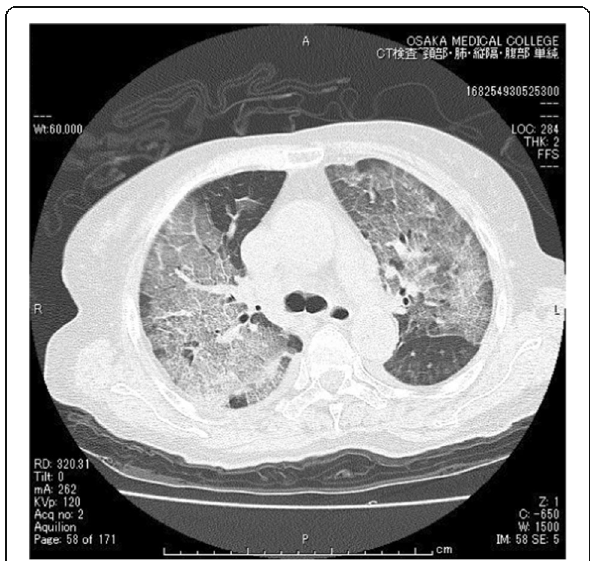
Fig. 5 Computed tomography indicated extensive bilateral infiltrates